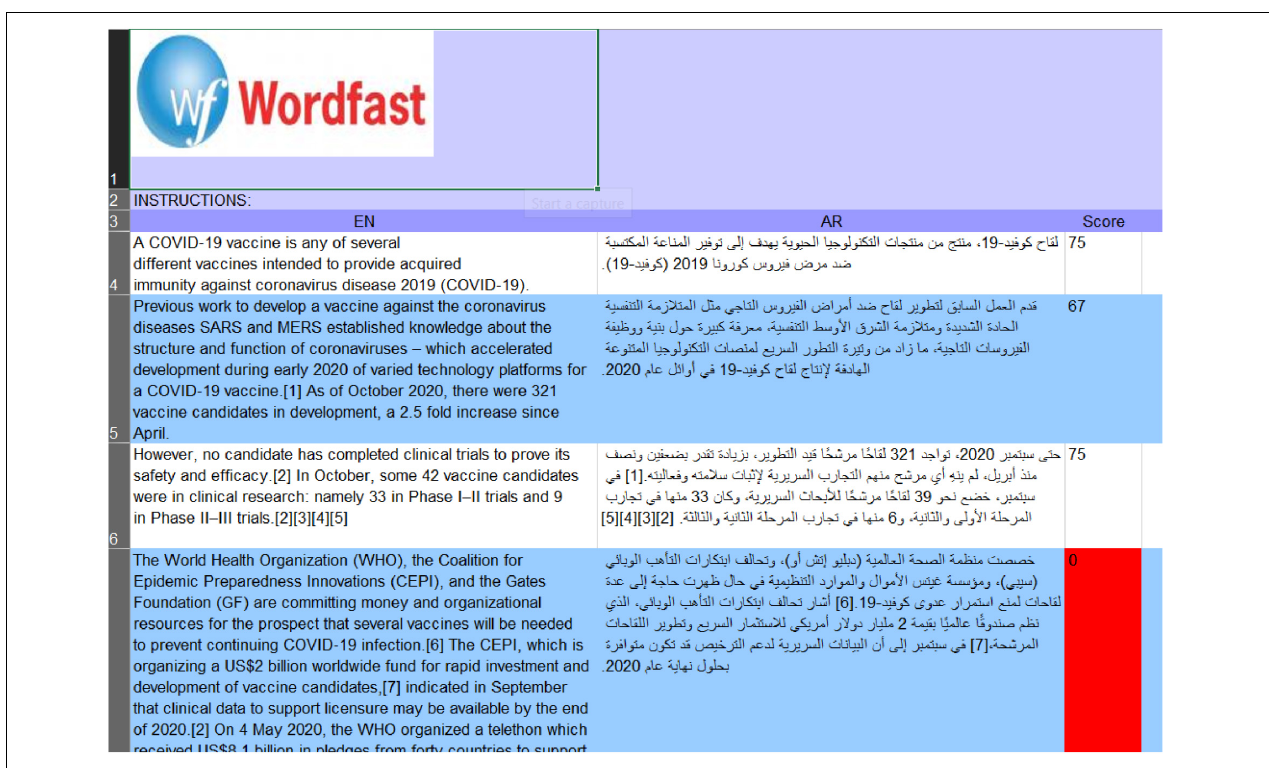
FIGURE 2 | Example of a comparable bilingual